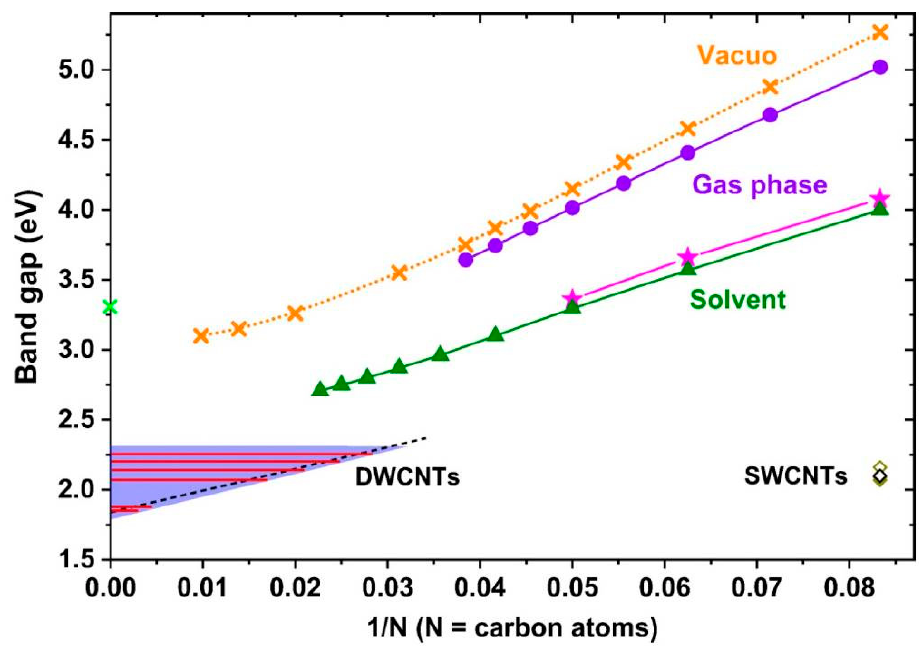
Figure 7. The band gap of finite carbon chains in dependence on the inverse number of atoms by first principle calculations ([9]: orange crosses), predicted [26] for carbyne (green cross), measured in gas phase (solid circles) [27] or for chains dissolved in a solvent (solid triangles and solid stars represent LCCs terminated by di ff erent chemical ending groups) [28,29] by absorption spectroscopy, and LCCs inside single (open squares [30,31]) / double wall nanotubes ([9]: the light blue shaded area) by resonance Raman spectroscopy. Reproduced with permission from [9].